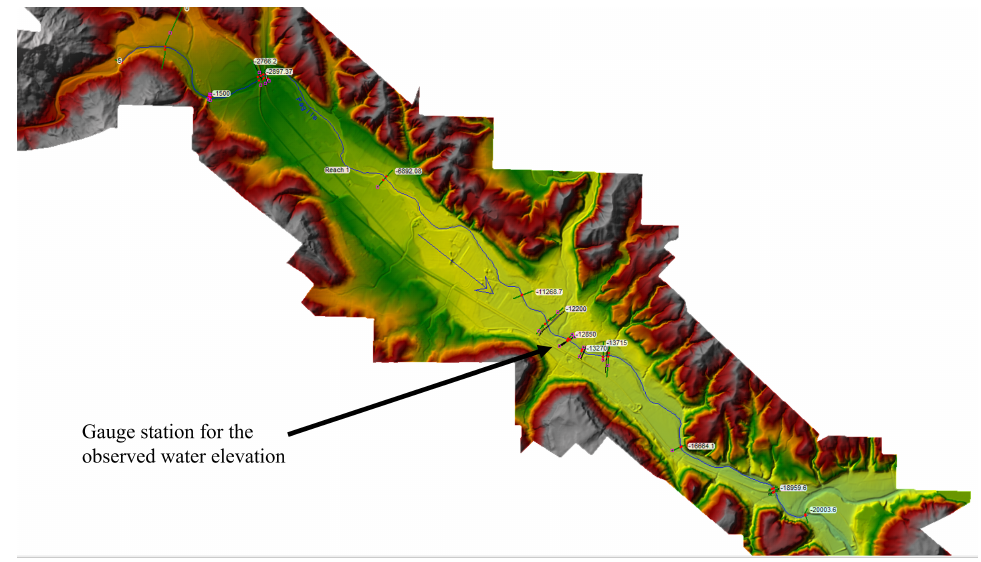
Figure 4. HEC-RAS visualisation of the of the cross section placed in the same position of the gauge